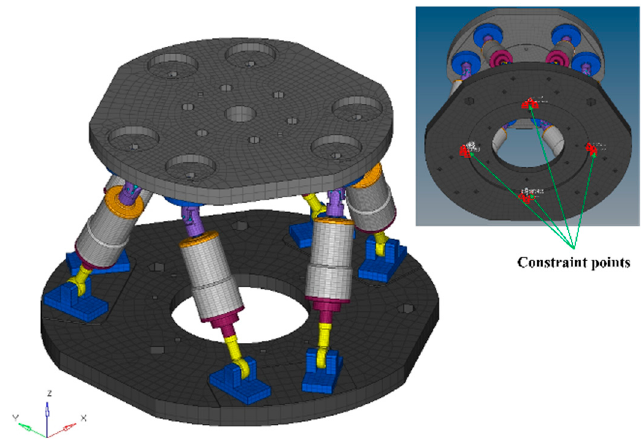
Figure 9. FEM model of the